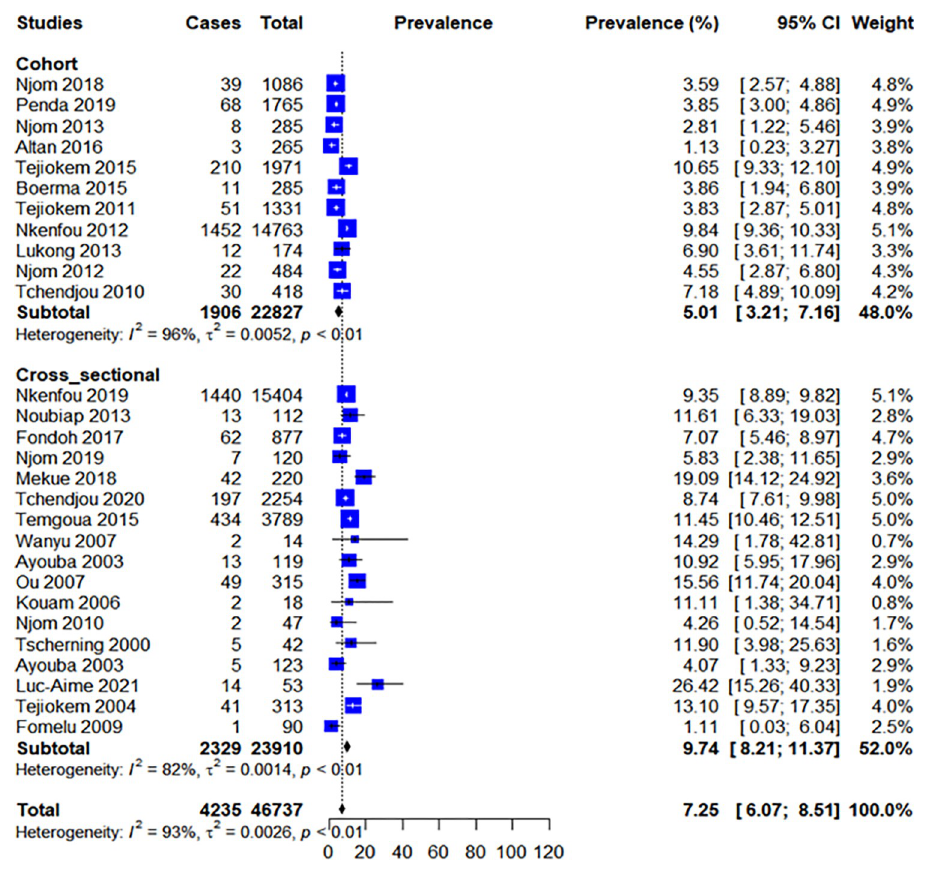
Fig 8. Forest plot of the prevalence of the MTCT according to study